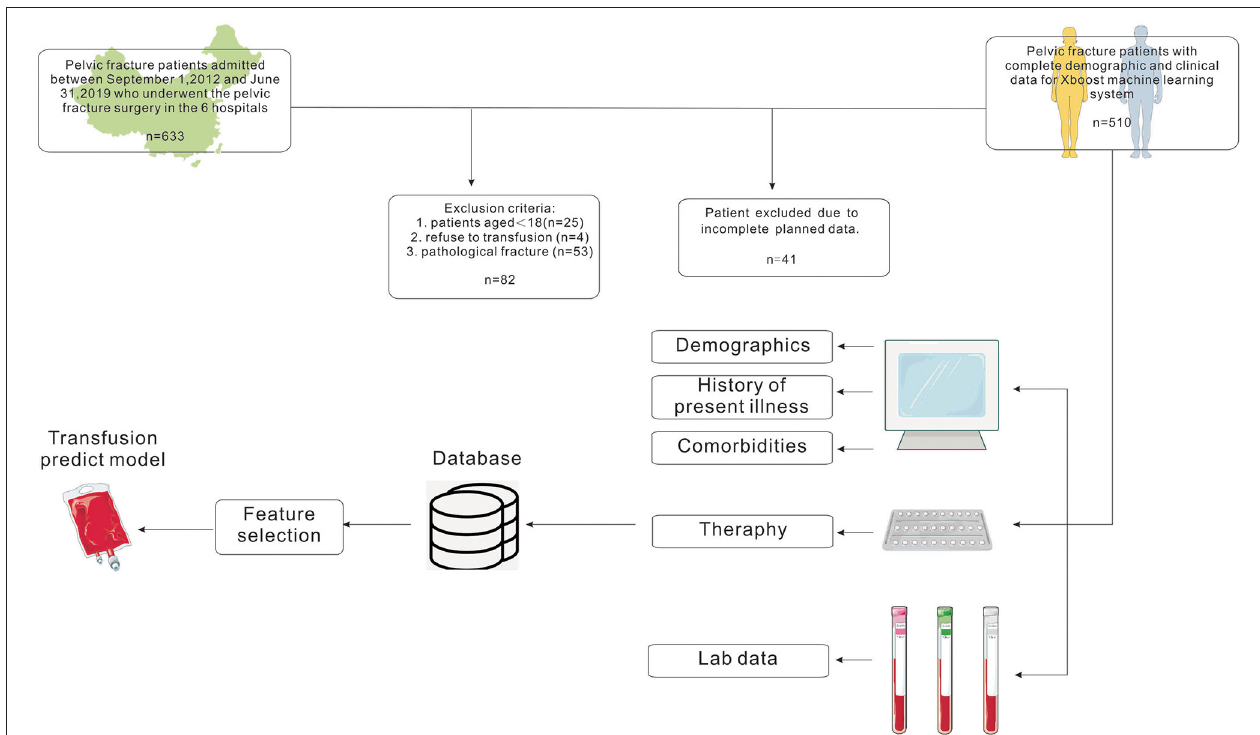
FIGURE 1 | Flow chart showing the inclusion and exclusion criteria of patients and model-making process for the